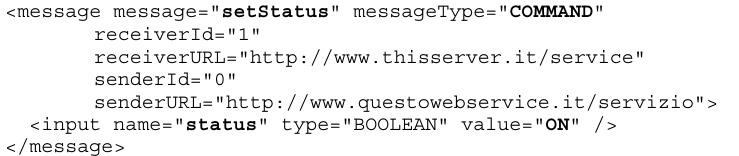
Figure 4. DomoMessage